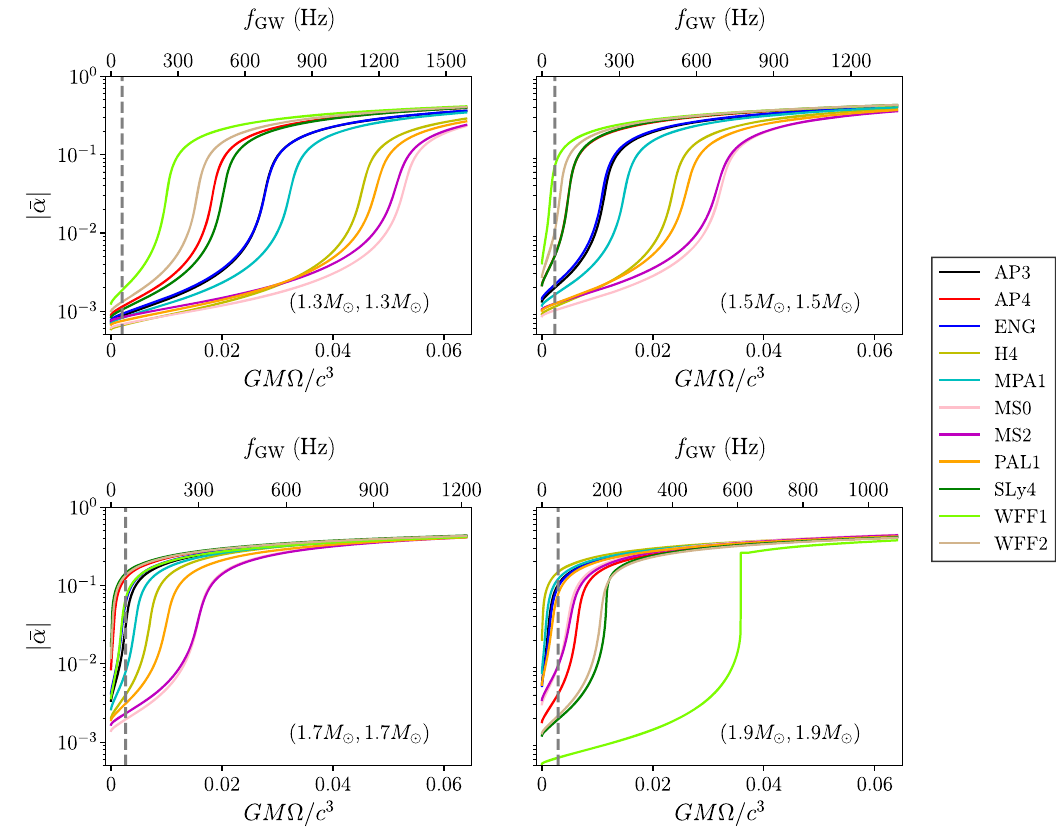
FIG. 10. Mass-averaged scalar coupling as a function of orbital angular frequency for equal-mass BNS systems with masses ð 1 . 3 M ⊙ ; 1 . 3 M ⊙ Þ , ð 1 . 5 M ⊙ ; 1 . 5 M ⊙ Þ , ð 1 . 7 M ⊙ ; 1 . 7 M ⊙ Þ , and ð 1 . 9 M ⊙ ; 1 . 9 M ⊙ Þ . We use the limits on ð α 0 ; β 0 Þ at 90% C.L.s, given in Ω = π . Dashed vertical lines highlight Table II, for each EOS. The corresponding GW frequency is given along the top axis, with f GW ¼ ≲ 50 Hz, derived in Refs. the conservative detectability criterion for aLIGO that f DS